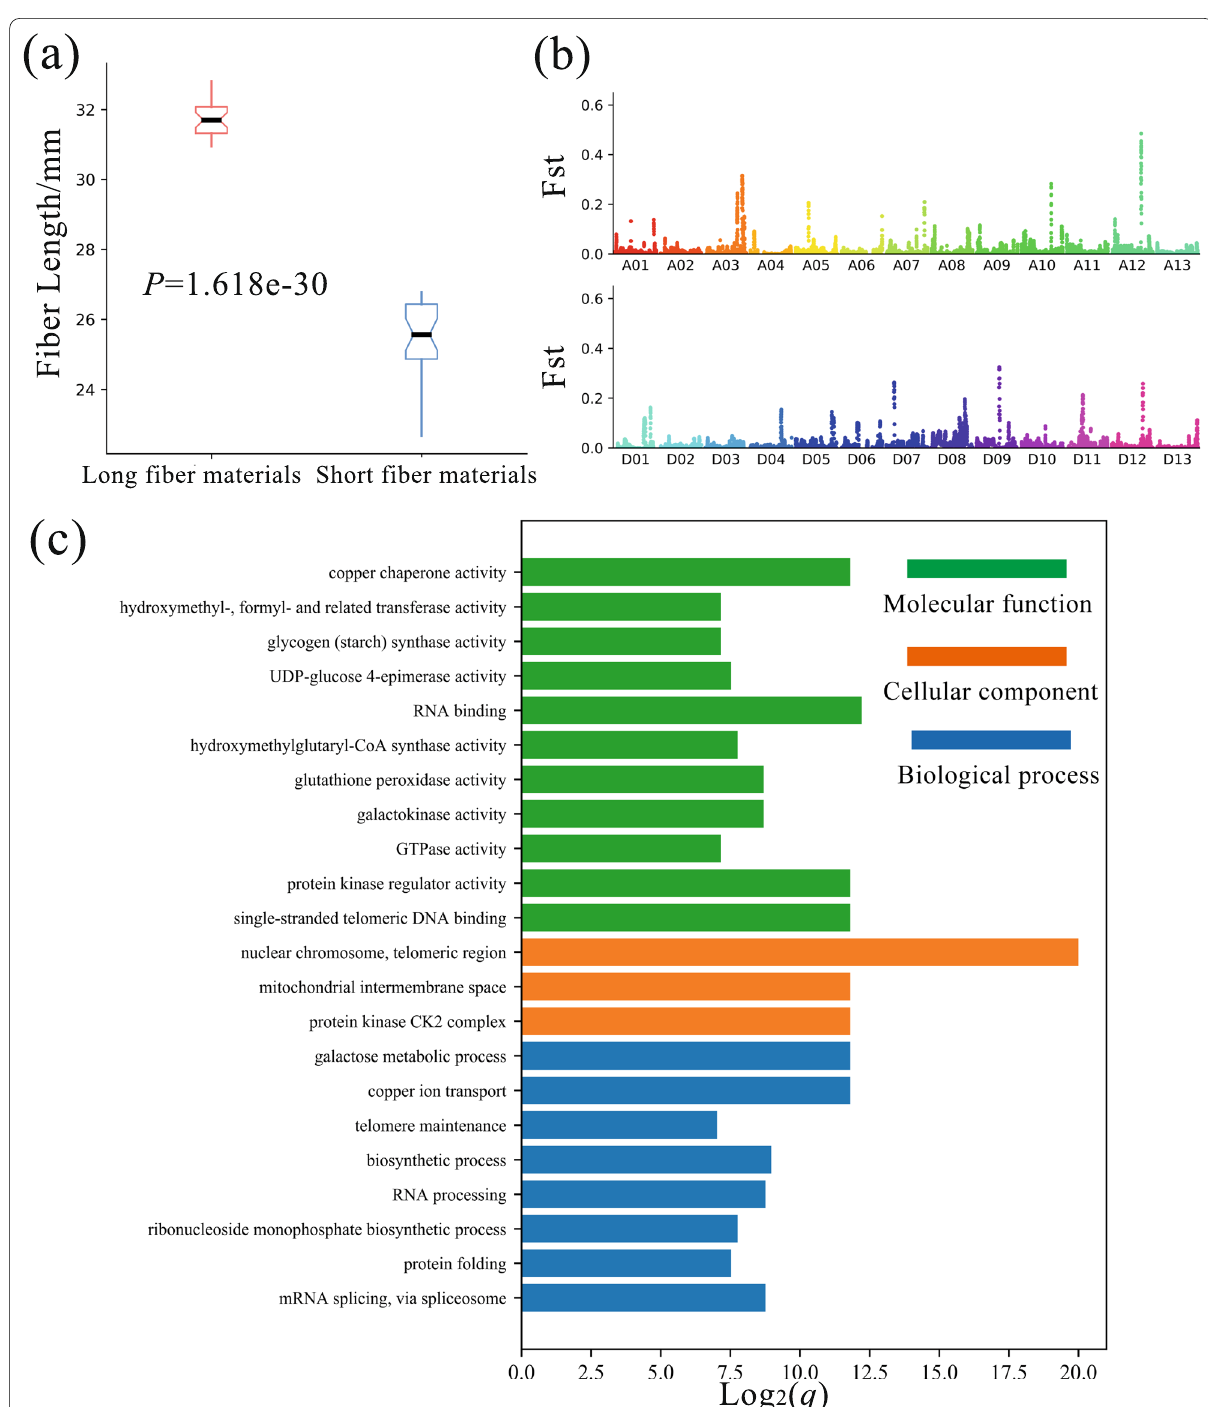
Fig. 3 Association analysis between genotype and phenotypic trait of fiber length. a phenotype divergence between long fiber and short fiber cultivars. b Manhattan plot of F st and location of window in association. c GO enrichment of genes overlapped with windows with the top 5% of F st